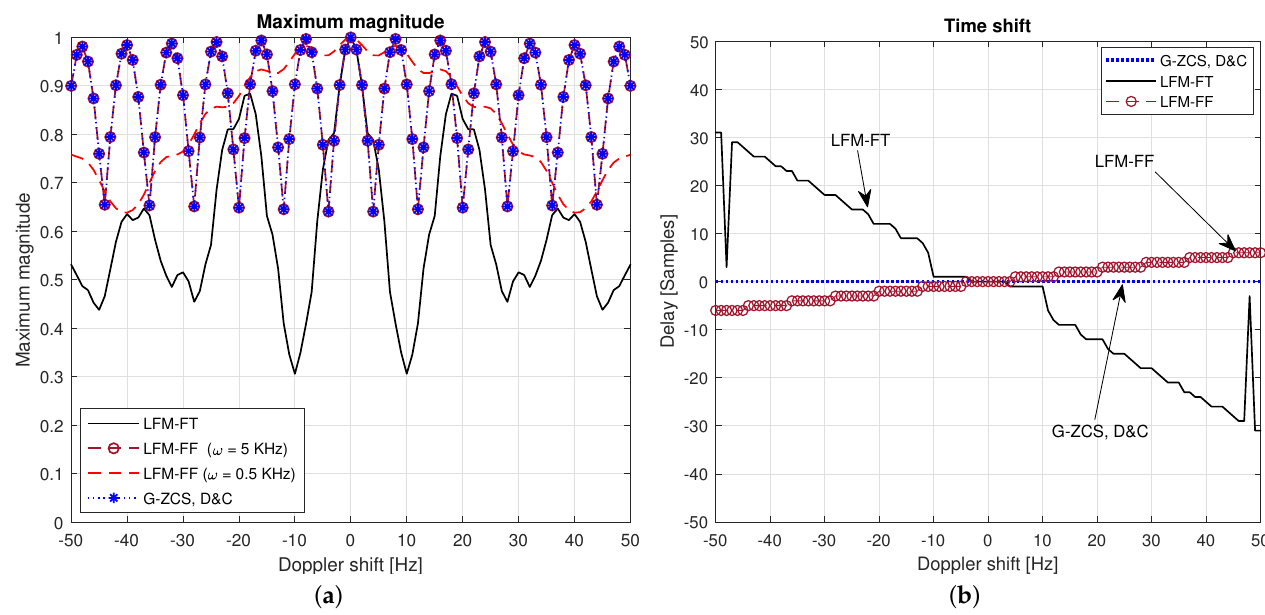
Figure 6. Maximum magnitude and time shift of ambiguity functions of previous and proposed sequences. ( a ) Maximum magnitude vs. Doppler shift. ( b ) Time shift vs. Doppler